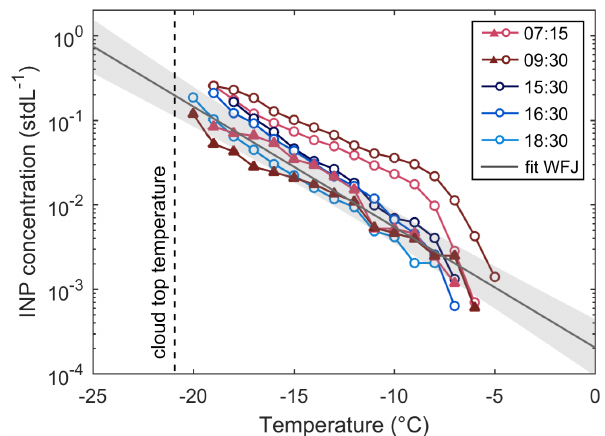
Figure 10. INP concentrations measured at Wolfgang (1630m, cir- cle) and Weissfluhjoch (2700m, triangle) for different temperatures and times, as indicated in the legend. The cloud top temperature of − 21 ◦ C is shown by the vertical dashed line. The dark gray line is a fit to the INP concentrations measured at Weissfluhjoch at tem- peratures between − 9 and − 17 ◦ C (pre-cloud INP conditions). The gray shaded area shows the 95% confidence interval of the fit which was used as an estimate of the upper and lower bounds of the INP concentration (see Fig.